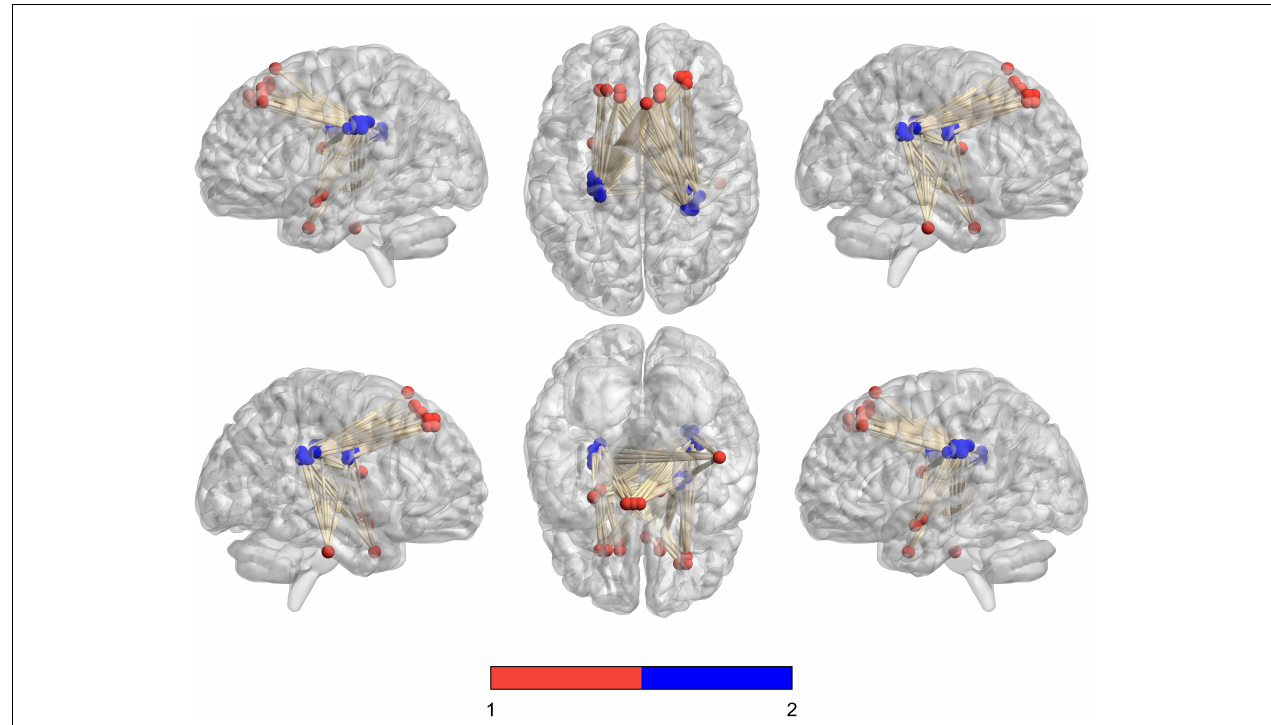
FIGURE 2 | Schematic diagram of the abnormal functional covariance connections between 19 gray matter voxels and 16 white matter voxels identified by FCC analysis between the PDH and HC groups. The red balls represent gray matter voxels, and the blue balls are the white matter